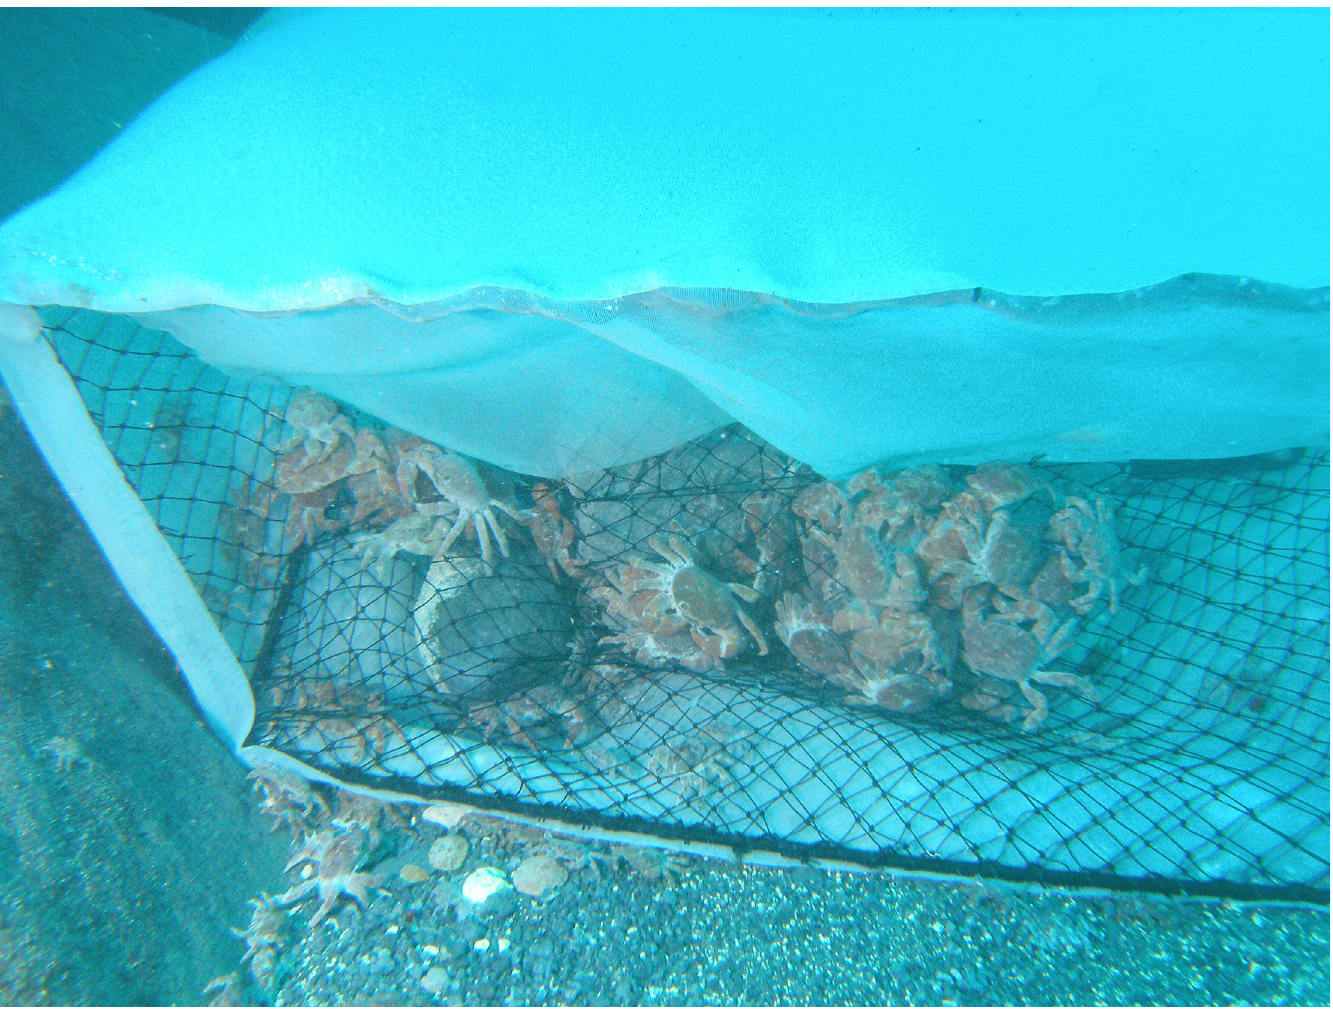
Fig 3. Photo of crabs and sampling trap.